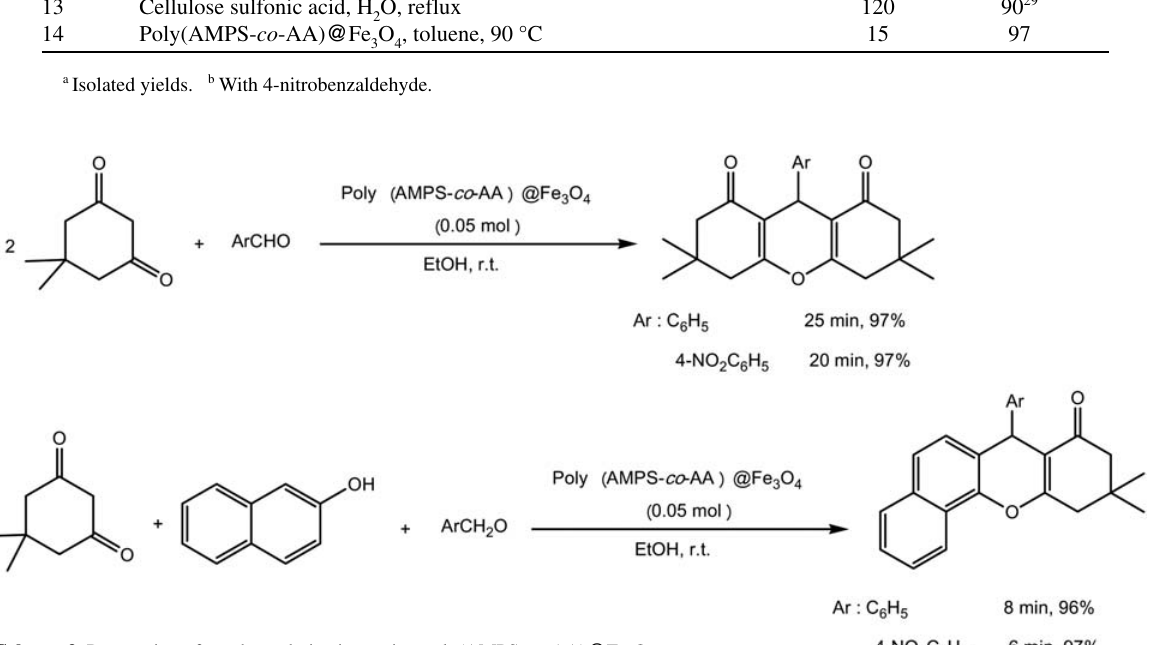
Table 2: Comparison results of poly(AMPS- co -AA) @ Fe benzaldehyde with two equivalents of 4-hydroxycoumarin.